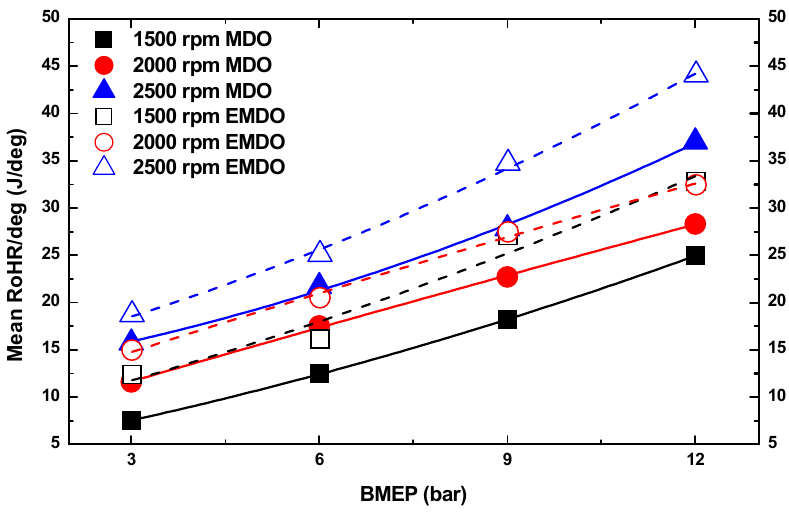
Figure 7. Characteristics of the mean heat release according to brake mean effective pressure (BMEP) and rpm.